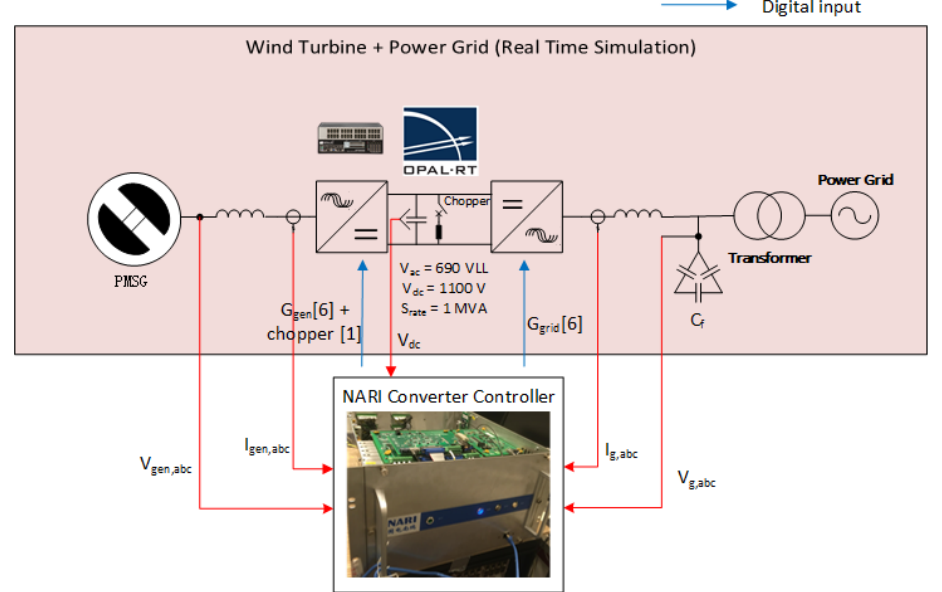
Figure 19. CHiL TB setup for the WT VSC controller replica impedance